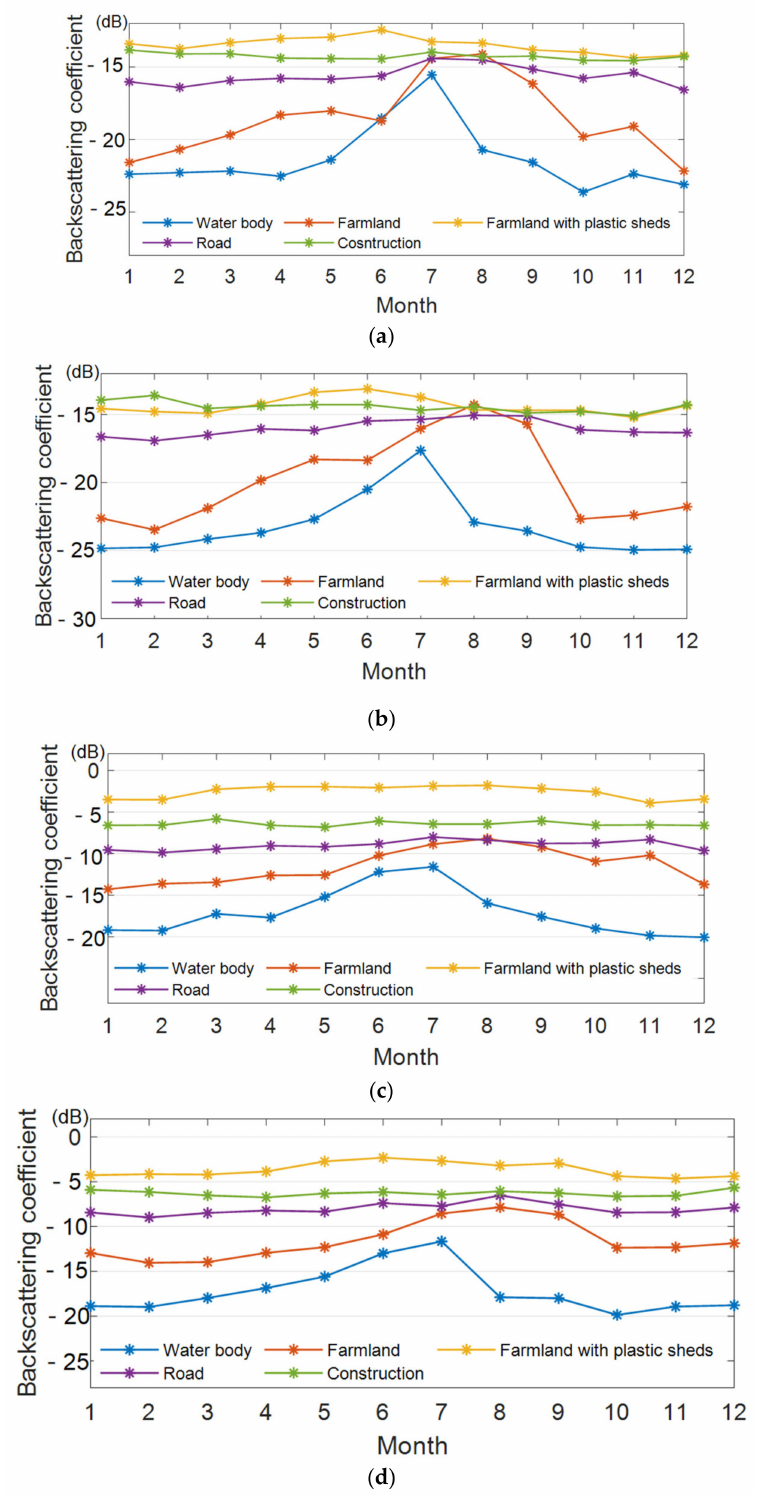
Figure 7. Monthly backscattering coefficients with different polarizations and orbits: ( a ) VH and ascending orbit; ( b ) VH and descending orbit; ( c ) VV and ascending orbit; ( d ) VV and descending